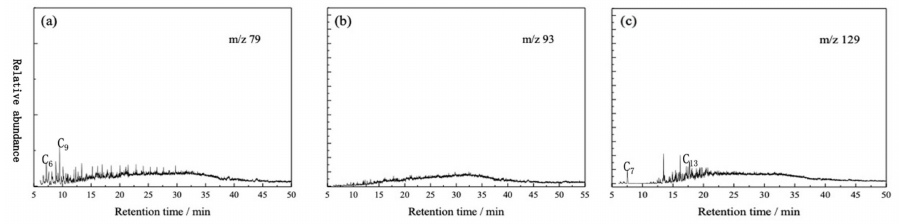
Figure 6. Spectra of nitrogen compounds. ( a ) The ion current spectra with m / z of 79; ( b ) The ion current spectra with m / z of 93; ( c ) The ion current spectra with m / z of 129.